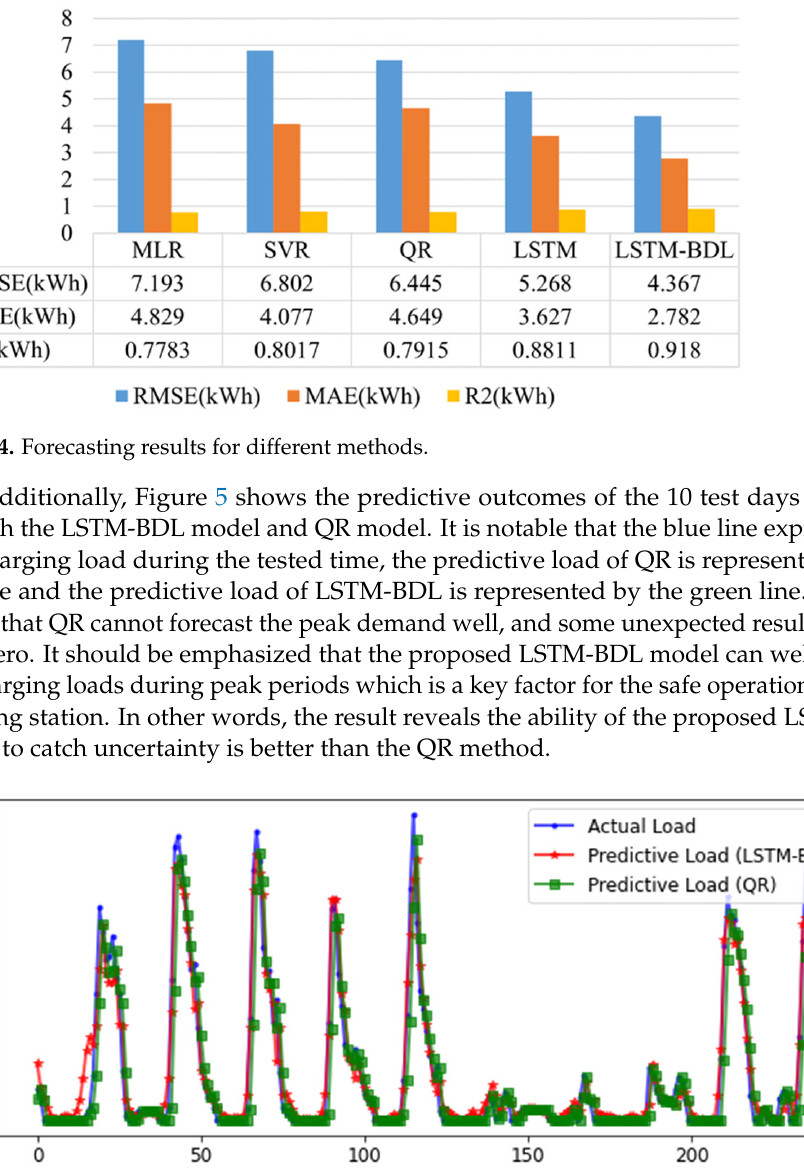
Figure 5. Probabilistic EV charging station load forecasting result.